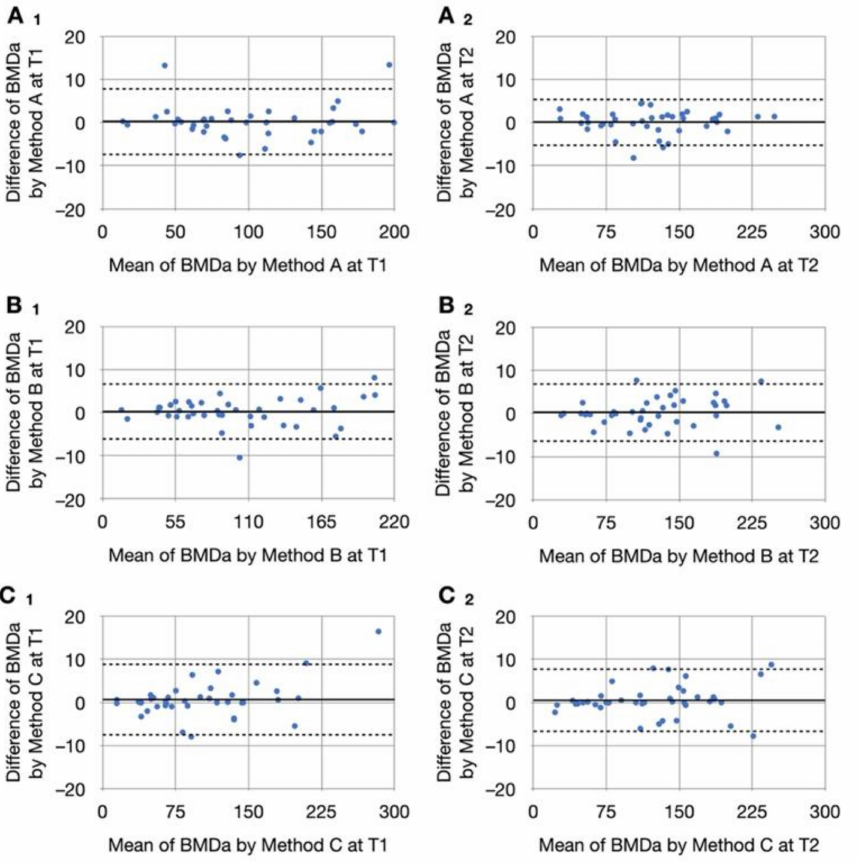
Figure 6. Distribution and consistency of results of two measurements using the same method and Bland–Altman plots. ( A 1 ), ( B 1 ), and ( C 1 ) plots are comparisons of two measurements conducted using Method A, B, and C, respectively, at T1; ( A 2 ), ( B 2 ), and ( C 2 ) plots are comparisons of two measurements conducted using Method A, B, and C, respectively, at T2. The mean values of differences in BMD a between two measurements of grafted tissue are approximately at and evenly distributed within the zero line, indicating that the two methods produced similar